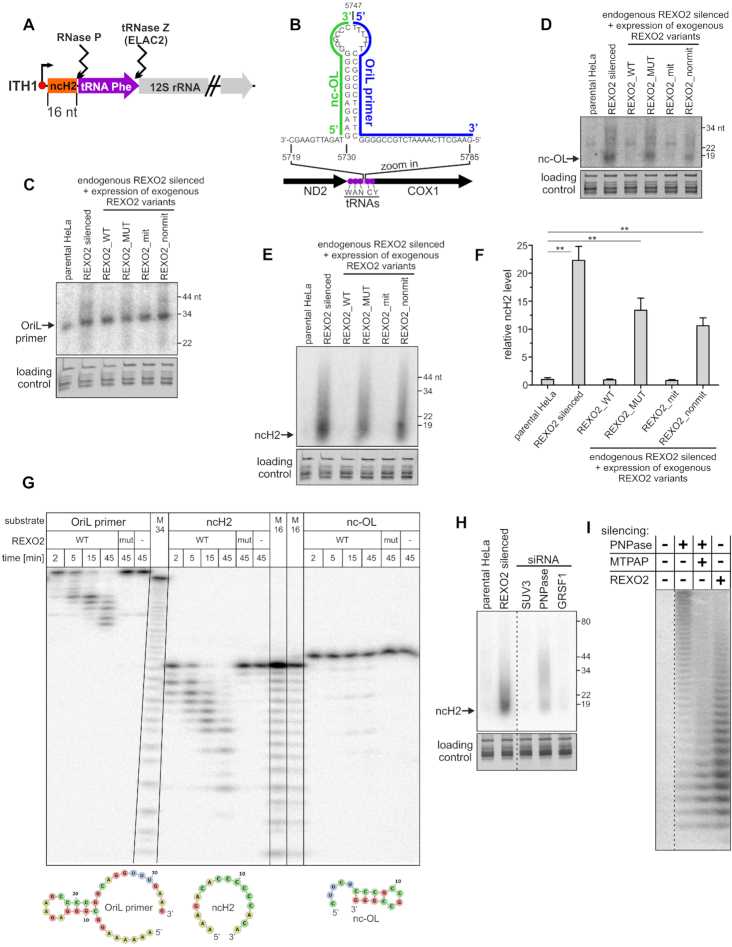
REXO2 silencing results in the upregulation of novel short RNA species. (A, B) Schematic representations of short transcripts. (A) Transcription initiation site (ITH) and the excision of tRNA lead to the formation of ncH2. (B) For nc-OL and the OriL primer, the OriL stem-loop region is shown. (C-E) Northern blot analysis of OriL primer, nc-OL transcript, and ncH2 transcript, respectively. Blots were performed on samples that were enriched with short (< 200 nt) mitochondrial RNAs. tRNA pool (GelRed staining) was the loading control. (F) Quantification of northern blot analysis of ncH2 levels (mean ± SEM, three biological replicates) calculated relative to parental HeLa cells. A two-tailed unpaired t-test was applied (**P 0.001 to 0.01). (G) Results of RNA degradation assay with recombinant REXO2 and the indicated substrates, whose sequences correspond to transcripts that were detected by northern blots that are shown in C-E. Secondary structures of the studied RNAs that were predicted by RNAfold software are shown in the bottom panel. WT, wild-type REXO2; mut, REXO2 mutant (D47A D168A); M34 and M16, RNA size markers obtained by alkaline hydrolysis. (H) Northern blot analysis of ncH2 levels in REXO2, mitochondrial degradosome subunits (SUV3 and PNPase), and GRSF1-silenced cells. Total cellular RNA samples were analyzed. (I) High-resolution northern blot analysis of ncH2 upon the silencing or co-silencing of the indicated genes. Total cellular RNA samples were analyzed.